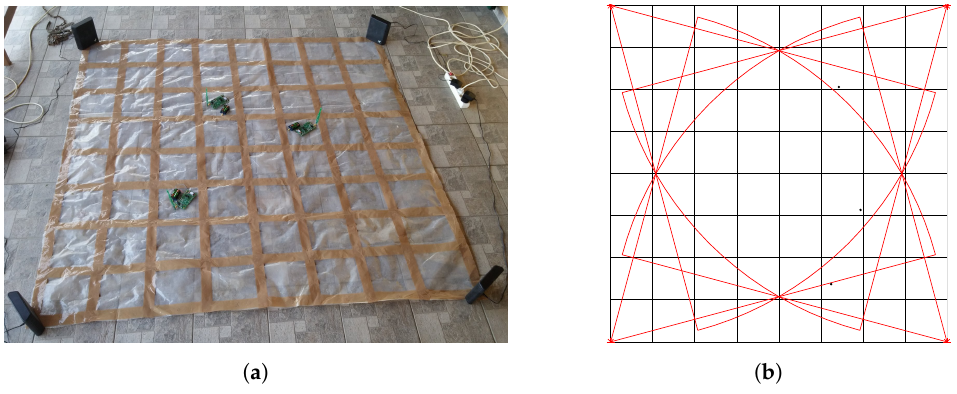
Figure 1. The testbed. (a) presents a snapshot of the testbed. (b) presents a graphical overview of the